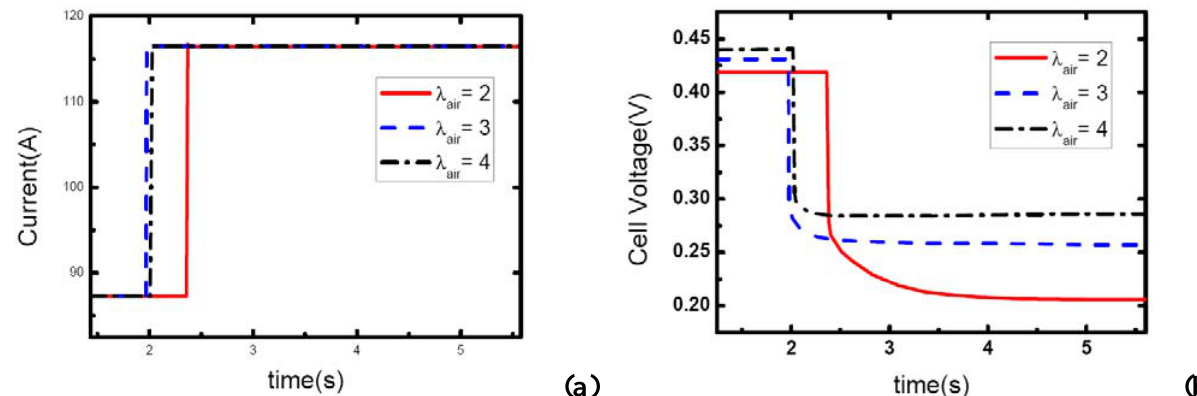
Figure 12. (a) Current change at three different stoichiometric ratios in cathode when the initial current is 88.5 A, (b) corresponding dynamic responses of